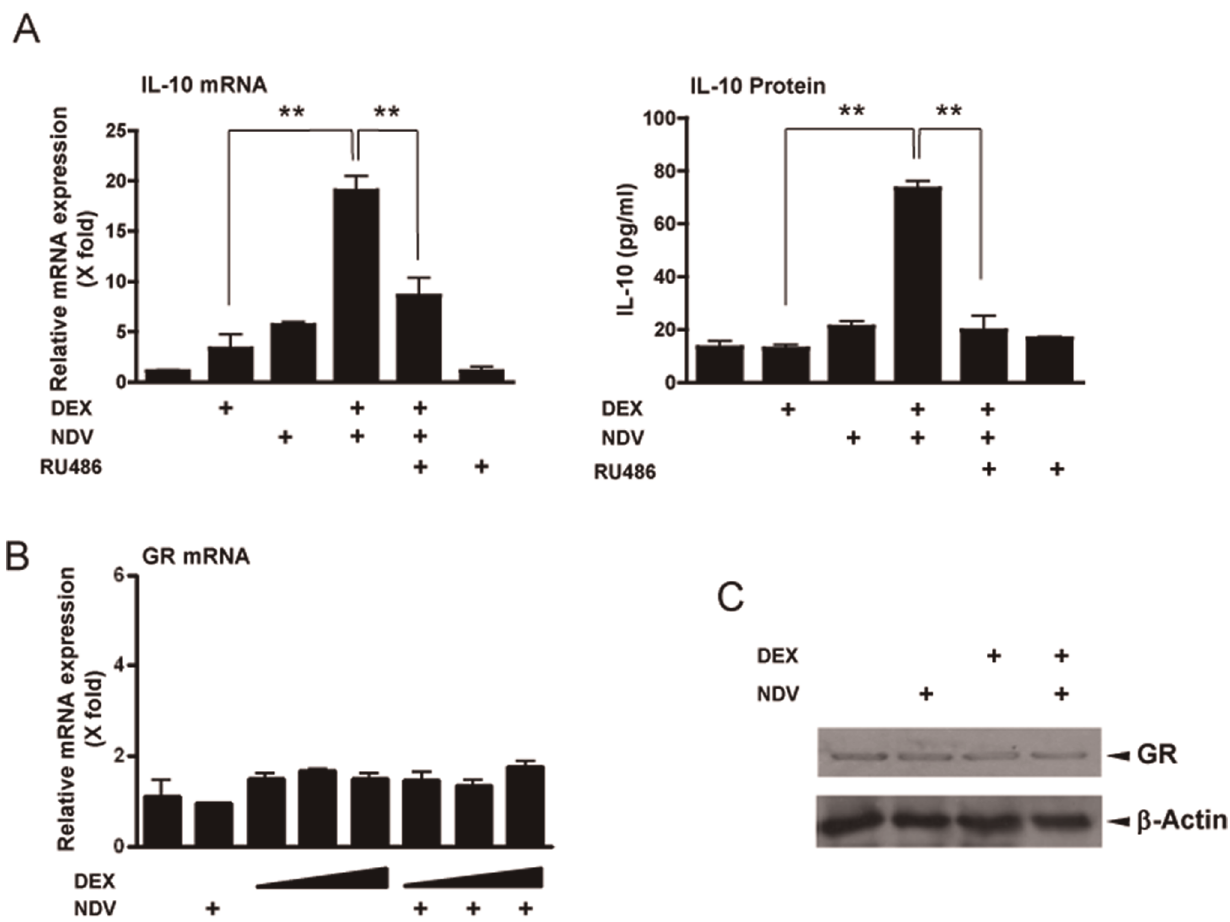
Figure 4. GR mediated DEX pre-treatment- and NDV infection-induced cooperative IL-10 mRNA expression in DCs. A . RU486 suppressed DEX-induced increase of IL-10 mRNA and protein expression in DCs. DCs were pre-treated with RU486 (10 2 5 M) and/or DEX (10 2 6 M) for 30 min, and were infected with NDV (MOI=10) for 6 hours. IL-10 mRNA and protein expression are shown. Bars represent means and standard errors of fold changes of the IL-10 mRNA expression and protein concentrations in culture media obtained from three independent experiments. **: p , 0.01, compared to the 2 conditions indicated. B & C . DEX pre-treatment and NDV infection did not change GR mRNA and protein expression in DCs. DCs were pre-treated with DEX (10 2 6 M) for 30 min, and were infected with NDV (MOI=10) for 6 hours. Bars in panel A and B represent means and standard errors of fold changes of the mRNA expression obtained in three independent experiments. Whole cell extracts obtained from DCs were run on SDS-PAGE gels, and GR and control b -actin were visualized with their specific antibodies in Western blots in panel C